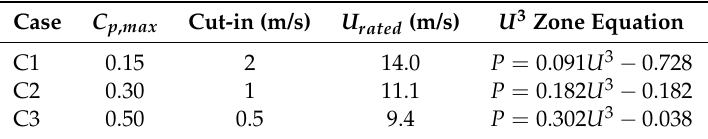
Table 3. Three paradigmatic cases (inferior limit, intermediate, upper limit) according to the improvement of efficiency in terms of C p , max and cut-in